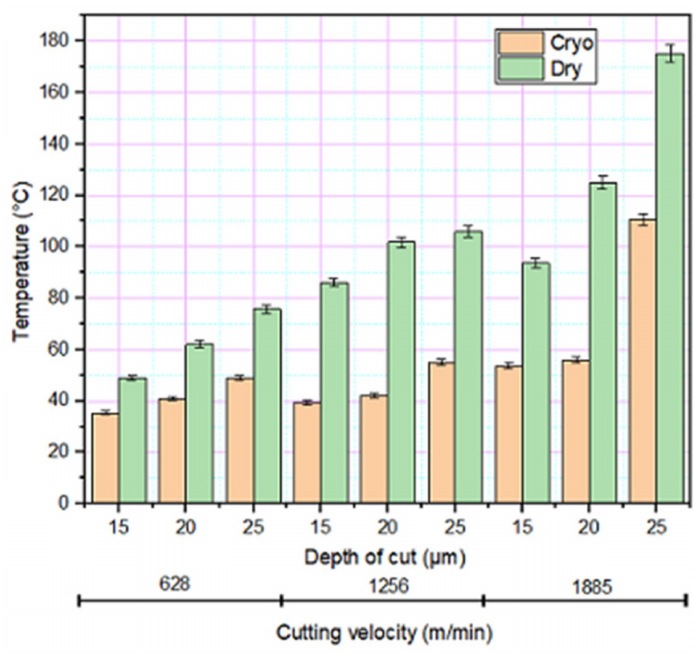
Figure 3. Variation in temperature under different grinding environments.